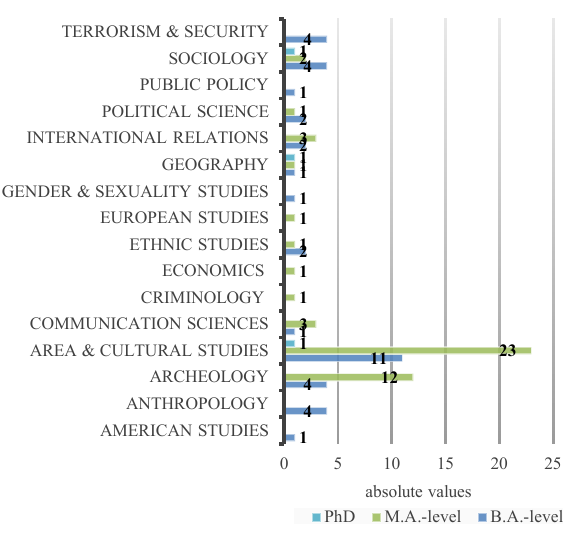
Figure 6. Domains of DCH in a social sciences